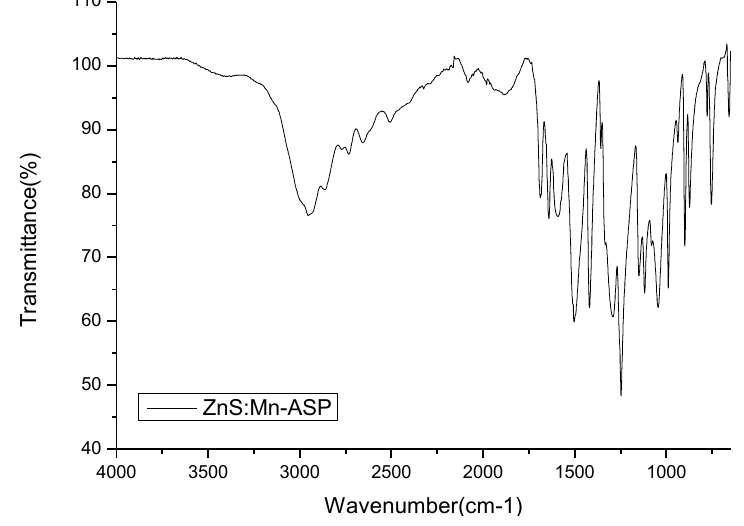
Figure 4. Fourier transform infrared (FT-IR) spectrum of the ZnS:Mn-Asp NCs. Table 1. FT-IR data and assignments of ZnS:Mn-Asp NCs. (units in cm −1 ).